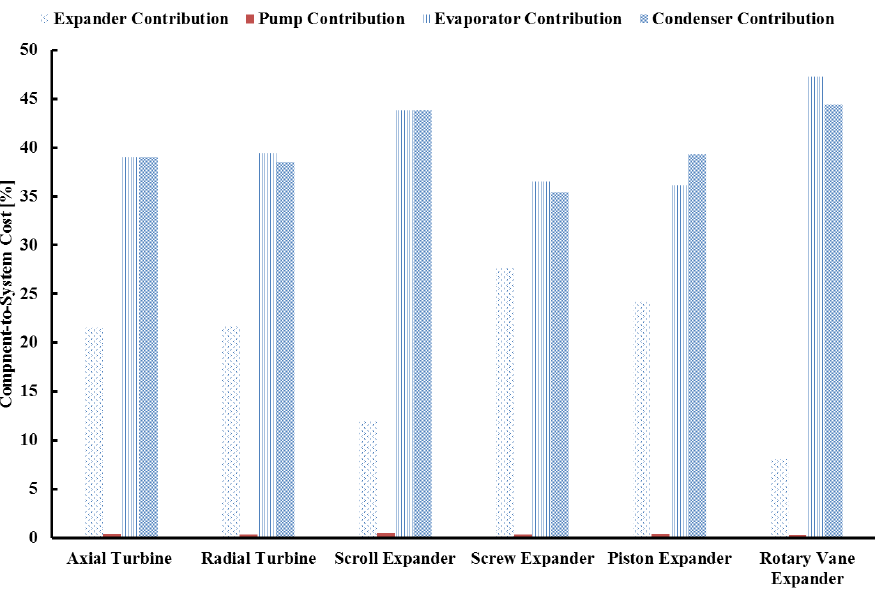
Figure 16. Contributions of components’ costs to total system cost.